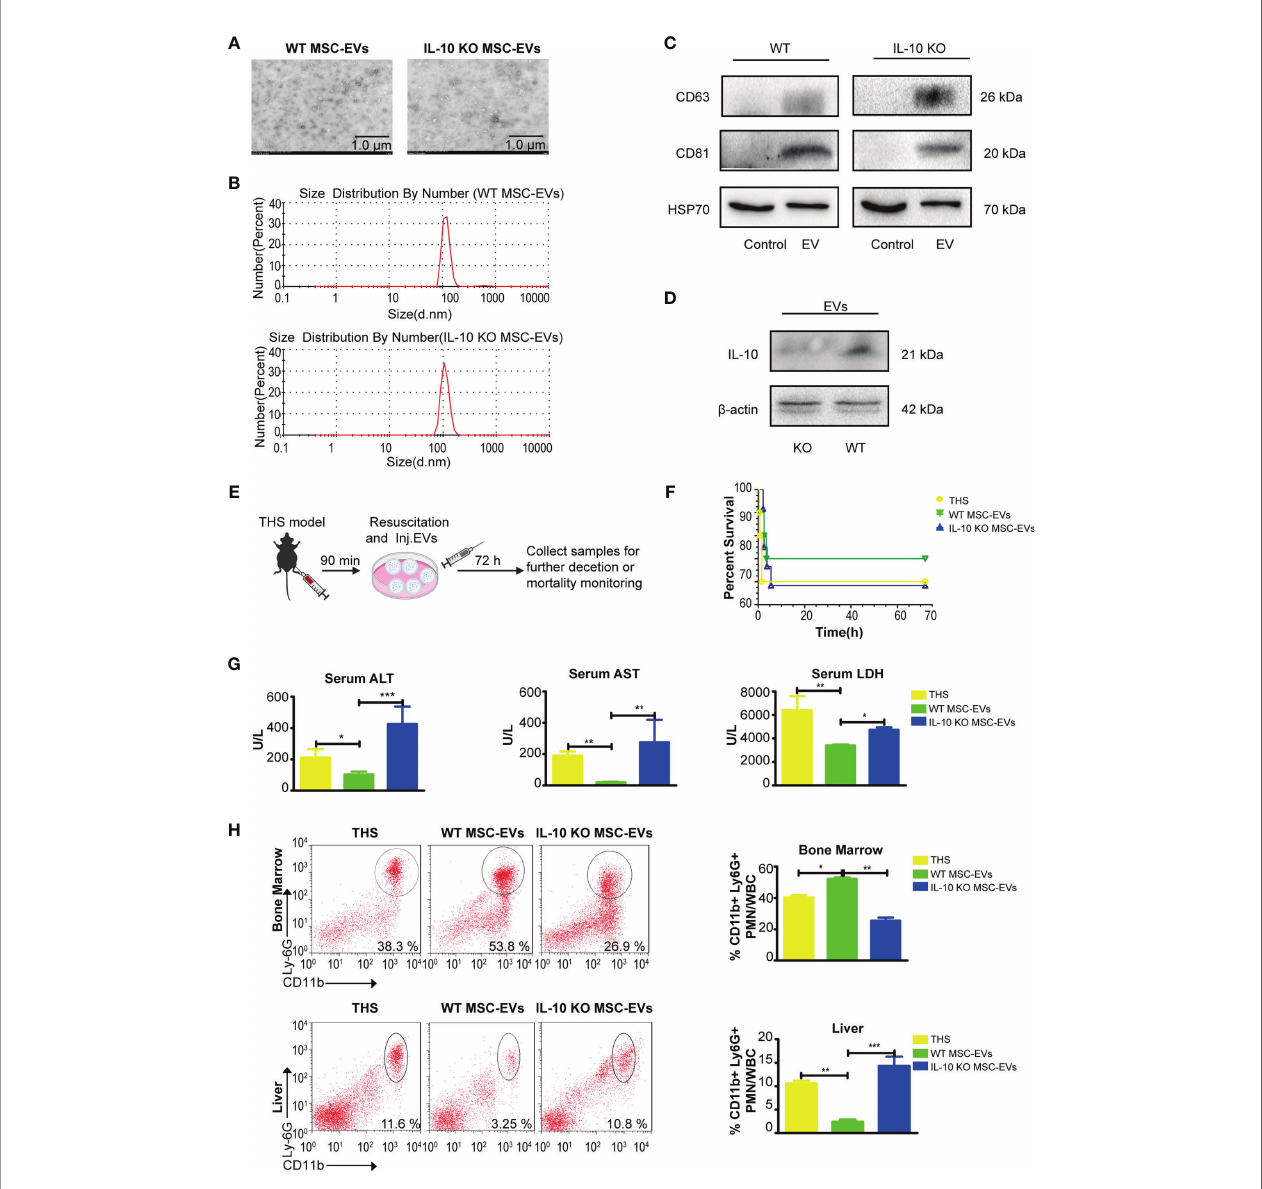
FIGURE 3 | WT MSC-EVs have protective capability in the THS model. (A) Identi fi cation of WT MSC-EVs and IL-10 KO MSC-EVs by TEM. Scale bar, 1 m m. (B) The size distribution of WT MSC-EVs and IL-10 KO MSC-EVs. (C, D) Western blot analysis of EV-associated protein markers CD63, CD81 and HSP70 (C) and IL-10 expression (D) in WT MSC-EVs and IL-10 KO MSC-EVs (The protein loaded of MSC-EVs was 20 m g). (E) Schematic diagram of the THS model treated with WT MSC-EVs or IL-10 KO MSC-EVs. (F – H) The survival rate of the indicated groups after 72 h resuscitation (n=10 – 12). (G) The plasma levels of LDH, ALT and AST were analyzed in the indicated groups by ELISA (n=3 – 5). (D) Flow cytometry analysis of neutrophils in bone marrow and liver tissues in the indicated groups (n=3 – 5). *P<0.05, **P<0.01, ***P<0.001. All data are shown as the one-way analysis of variance of the